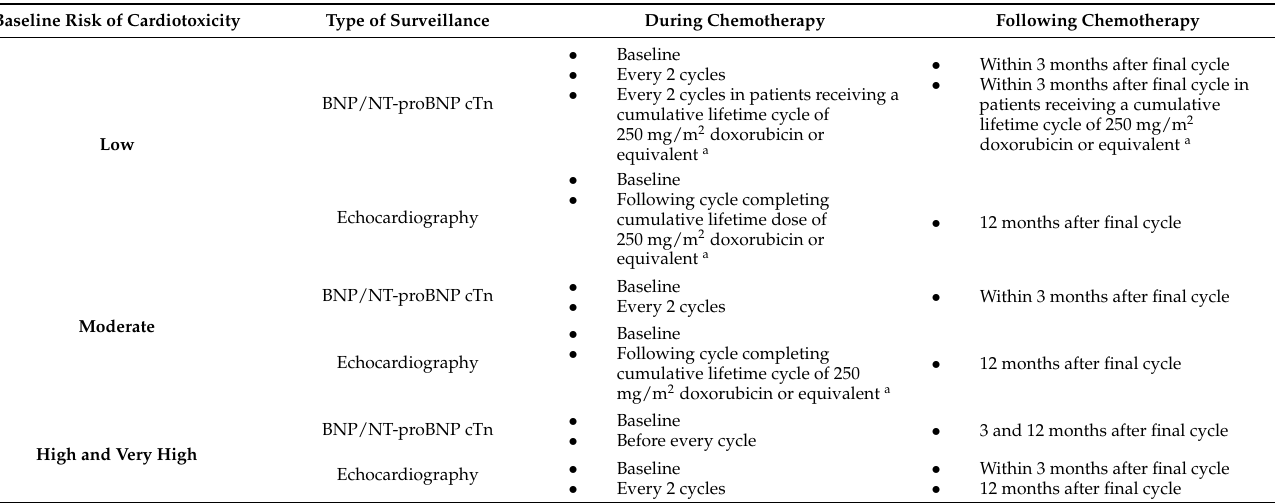
Table 2. Biomarker (circulating and imaging)-based surveillance during and after anthracycline therapy. Baseline Risk of